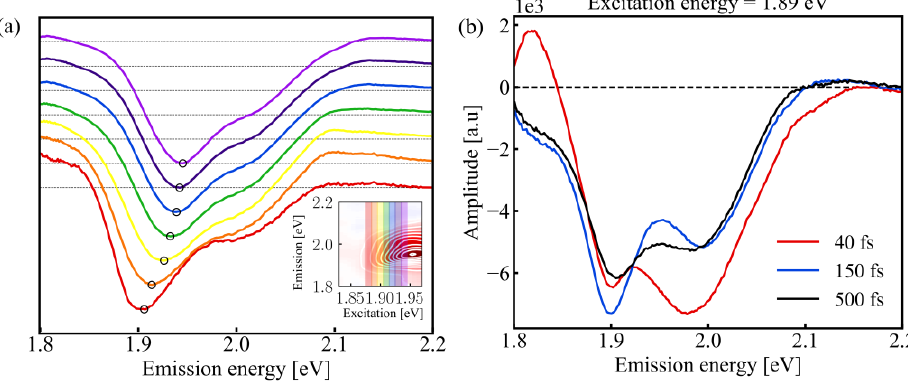
Fig. 2. (a) Pseudo-TA slices can be obtained for various values of excitation energy, here ranging from 1.88 eV (dark red) to 1.94 eV (purple) and for a population time of 40 fs. The colors match those shown in the inset. The minimum of each projection is indicated by a black hollow circle.(b) Projections at an excitation energy of 1.89 eV for representative population times of 40 fs (red), 150 fs (blue) and 500 fs